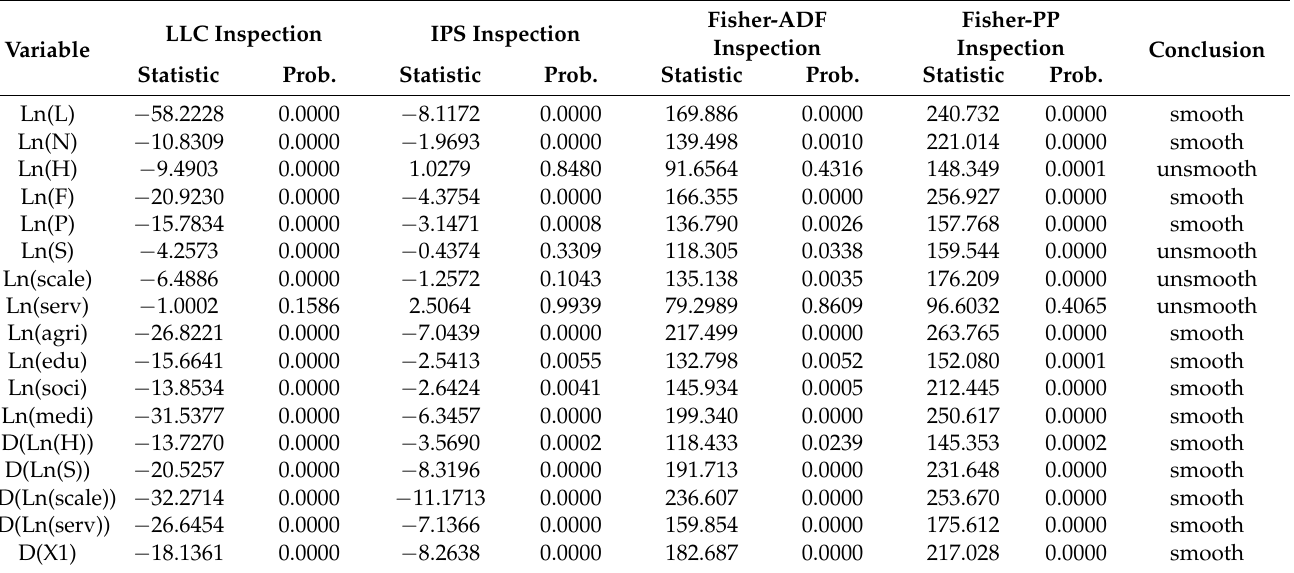
Table 1. Results of unit root test.